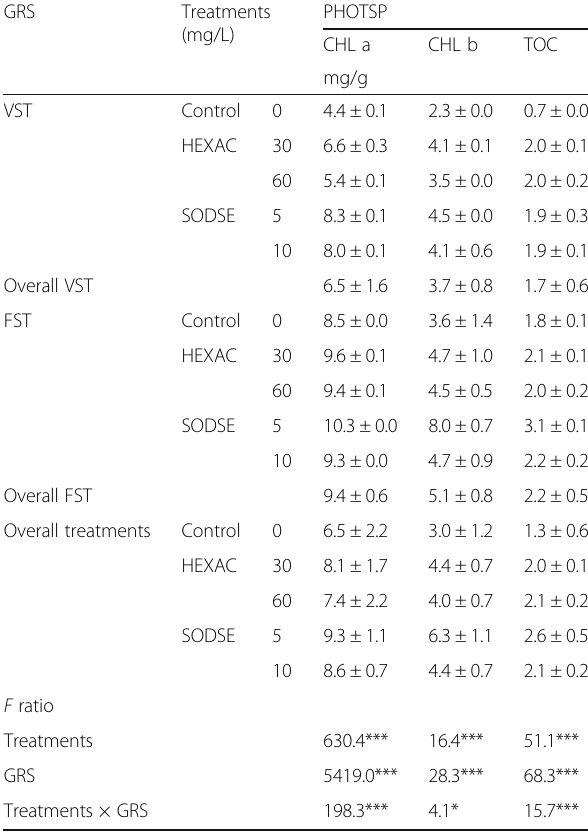
Table 3 Effect of HEXAC or SODSE on PHOSP GRS